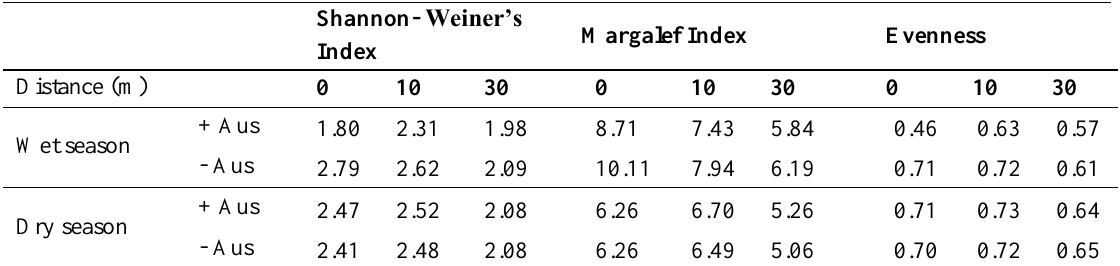
Table 2: Shannon-Weiner’s diversity index, Sorenson’s similarity Index [calculated with (+Aus) or without (- Aus) Austroeupatorium ] of soil seed banks at 0, 10 and 30 m distances away from the forest grassland edge